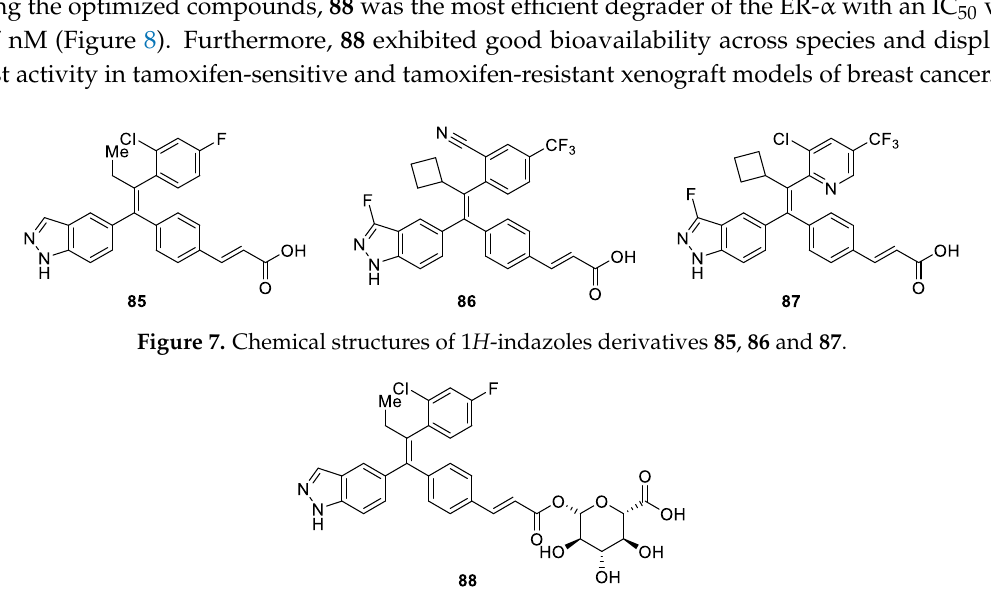
Figure 6. Chemical structure of azaindazole derivative 84.